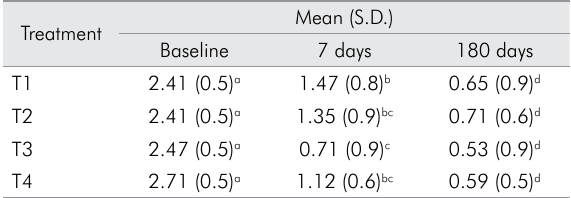
Table 3. Mean CDH scores variation (SD) at 7 and 180 days of observation when compared with baseline, according to